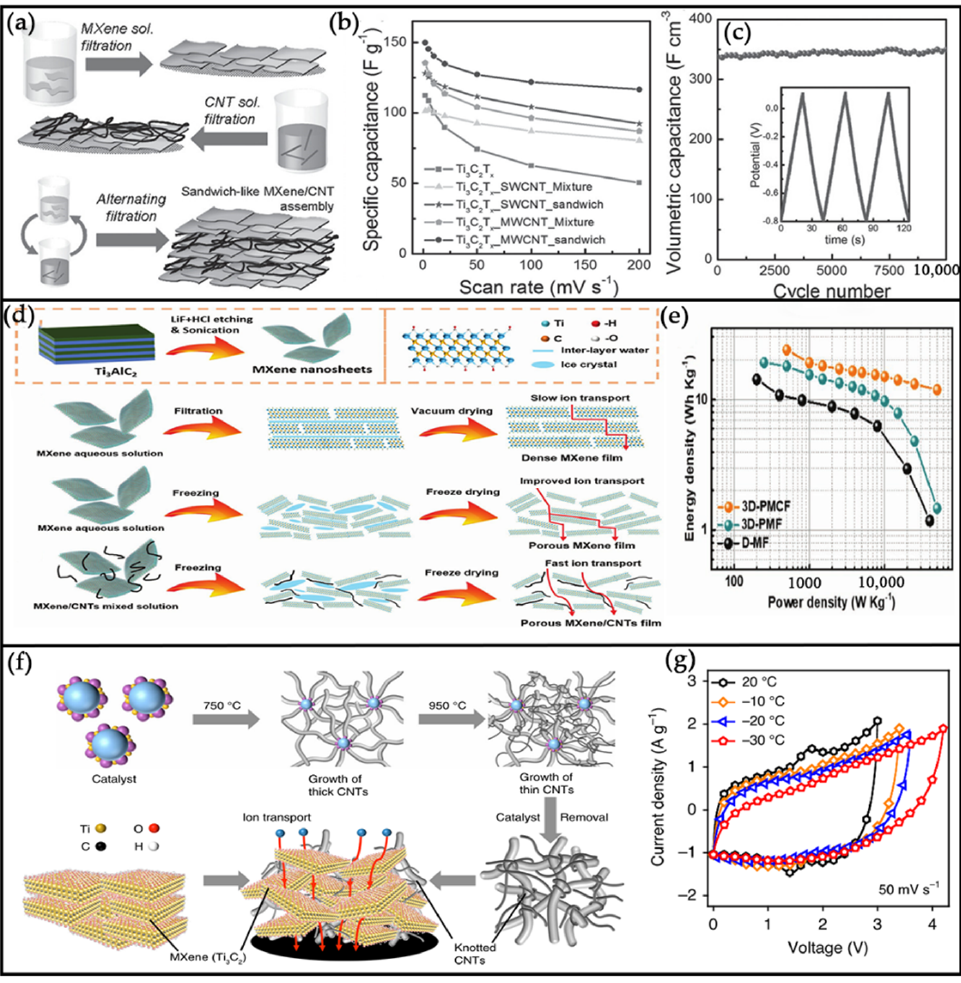
Figure 9. ( a ) The fabrication of MXene/CNT papers. ( b ) Gravimetric capacitances of Ti 3 C 2 T x